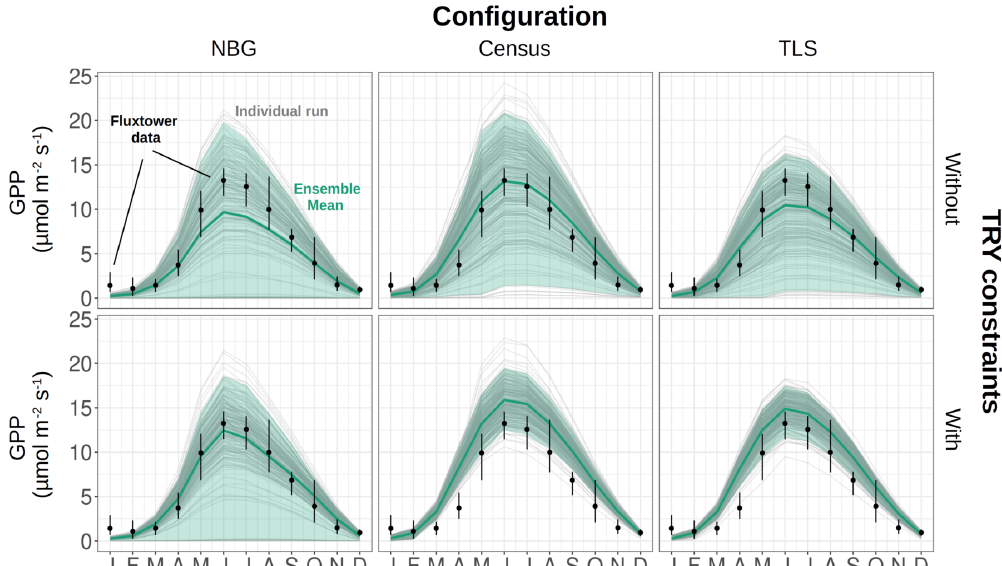
Figure 3. Seasonal cycle of the ecosystem GPP, as observed by eddy-covariance data (black dots) or as simulated by ED2.2 for multiple model configurations (columns) and with or without TRY constraints on SLA and V c , max (rows). The thick green lines are the ensemble means, while the shaded envelopes encompass 95% of the ensemble members. The individual ensemble members are also plotted as thin grey lines. The vertical error bars for the flux tower data represent the 95% confidence interval of the monthly GPP. The settings of the model configurations are detailed in Table 5.